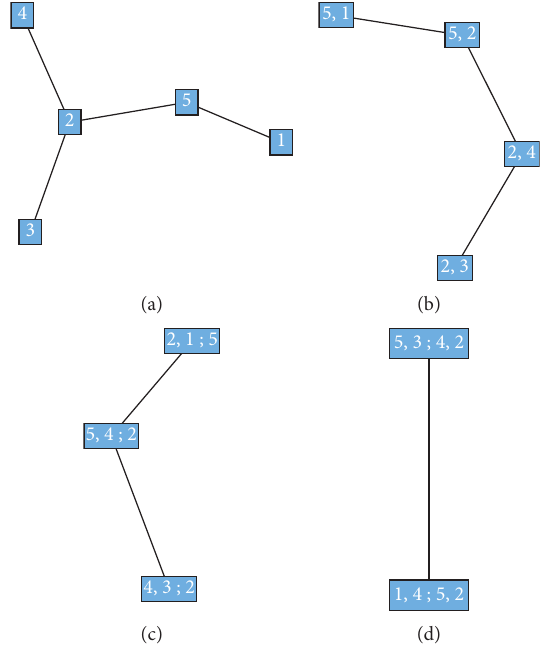
Figure 7: The R-vine tree structure of the Glass data.